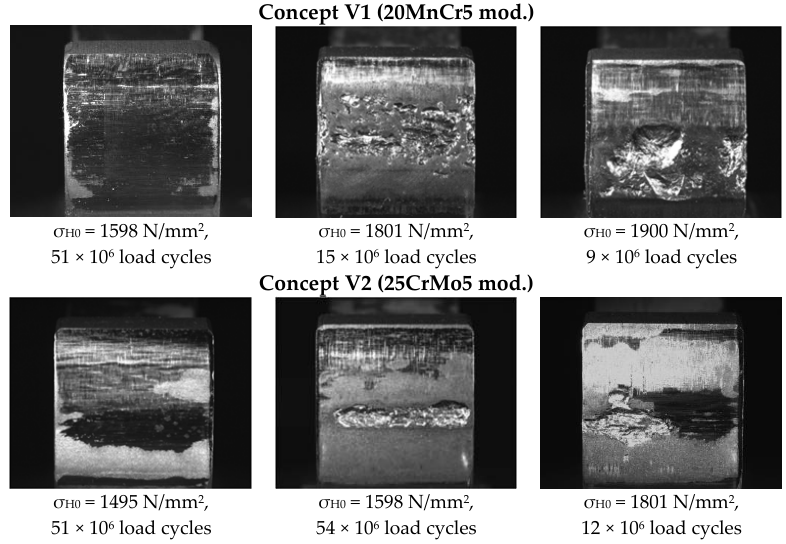
Figure 15. Examples of the typical tooth flank condition at the end of the test runs for various nominal contact stresses and load cycles (tooth width is 14